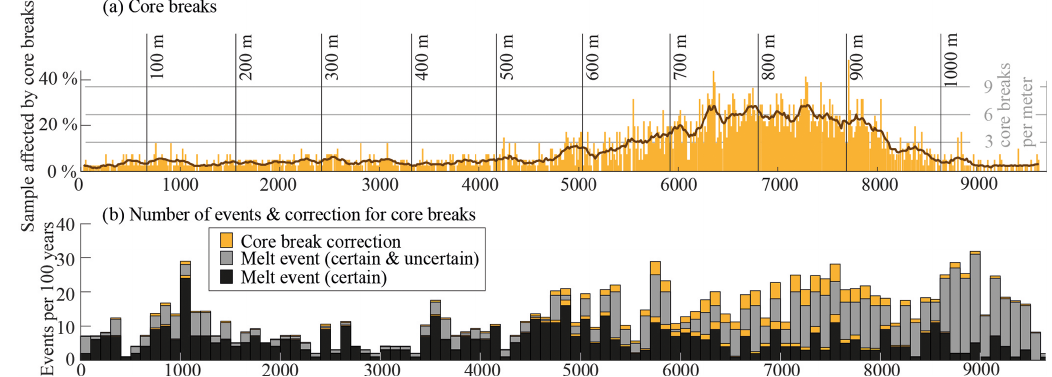
Figure 6. (a) Percentage of a 165cm sample affected by core breaks (orange bars, scale on the left side), number of core breaks per meter (orange bars, scale on the right side), and running mean over 16.5m (brown line). The broad peak between 650 and 950m depth indicates the brittle zone. (b) Certain melt events (black) and uncertain melt events (gray) corrected for potentially missed events in the proximity of core breaks